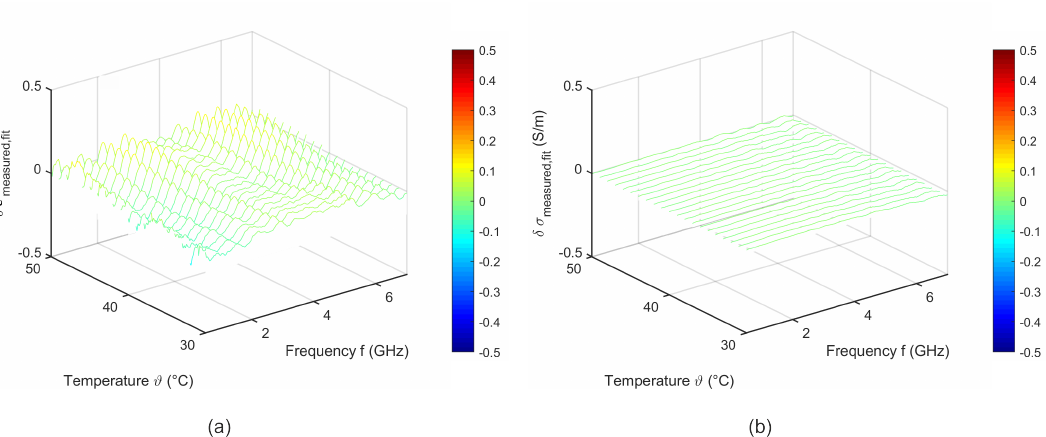
Figure 15. Difference between the measured data and the temperature dependent two pole Cole-Cole model of ( a ) relative permittivity and ( b ) effective conductivity of porcine